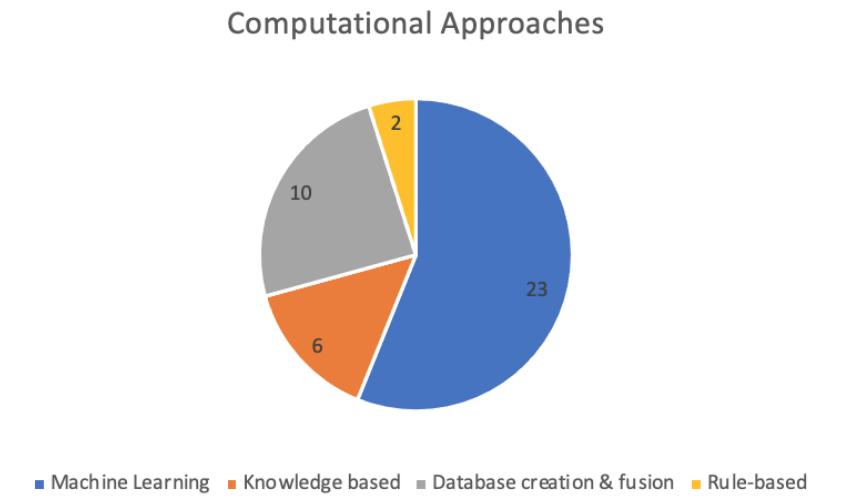
Figure 4. A chart showing the computational methods utilised in the selected articles.